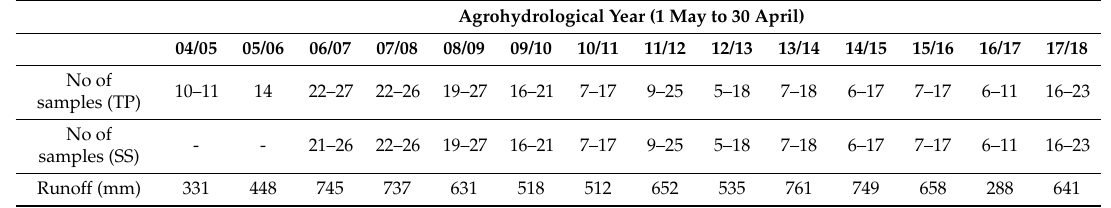
Table 3. The variation in annual number of water samples for total phosphorus (TP) and suspended sediment (SS) from 1 May to 30 April in 2004 to 2018 for the streams of the six catchments sampled. Annual runoff (mm) measured in the Skuterud